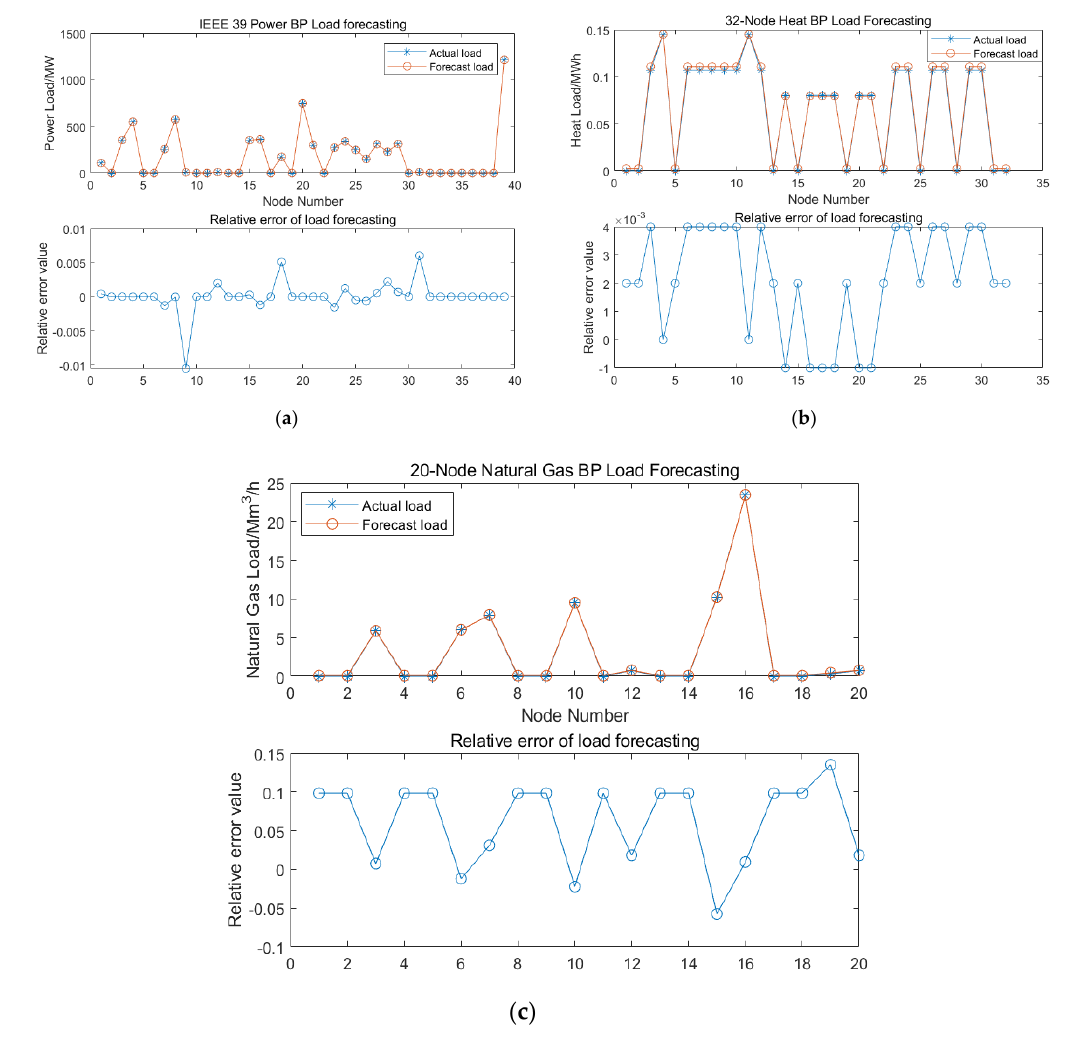
Figure 6. BP neural network load forecasting for: ( a ) IEEE 39 bus system; ( b ) 32-node heat network;